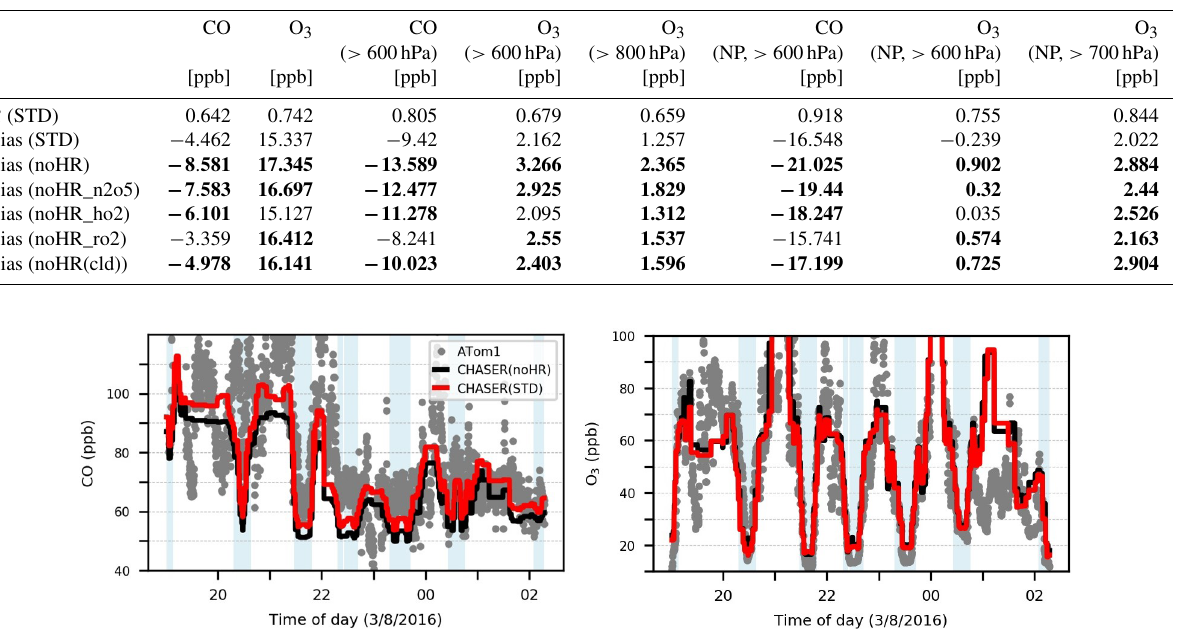
Table 8. Model correlations and biases with ATom1: three-sigma-rule was applied for CO and O 3 . NP denotes North Pacific region (140– 240 ◦ E, 40–60 ◦ N). The bias of the sensitivity run is presented in bold when it is higher than the bias of STD run. R has no unit; the units in brackets are for biases.